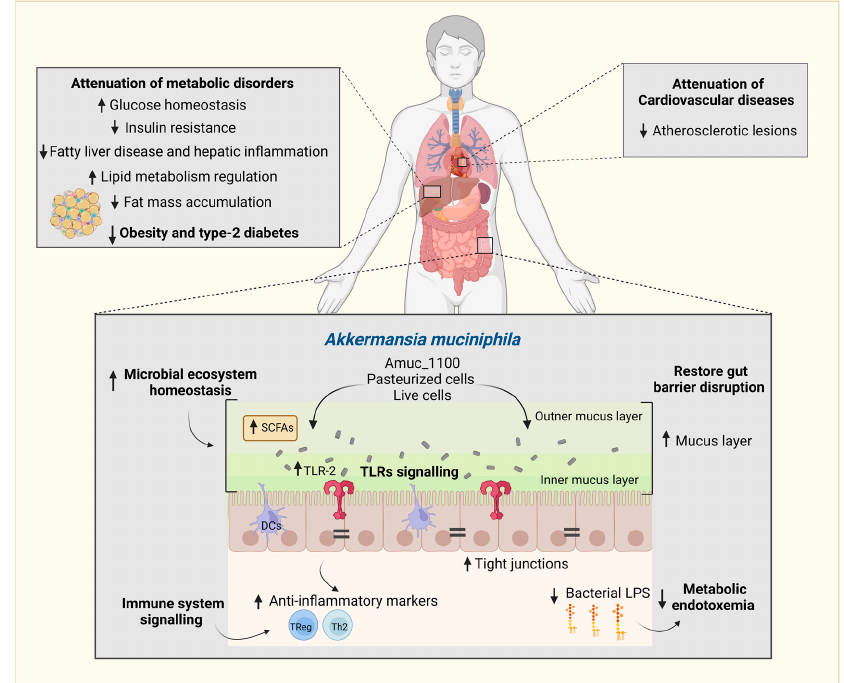
Figure 1. Beneficial impact of Akkermansia muciniphila on host health. A. muciniphila protects against cardiovascular diseases, metabolic disorders, and intestinal microecological disruption. An increased relative proportion of A. muciniphila in the gut microbiota has been inversely associated with obesity and type 2 diabetes. The administration of active A. muciniphila ; its membrane protein, Amuc_1100; and pasteurized cells can reverse metabolic disorders associated with a high-fat diet, obesity, and type 2 diabetes. Clinical and preclinical studies highlight the role of A. muciniphila in attenuating fat mass accumulation, adipose tissue inflammation, insulin resistance, and glucose homeostasis. A. muciniphila alleviates chronic intestinal inflammation and metabolic endotoxemia (reduces the level of lipopolysaccharide (LPS)) and induces immune cell and Toll-like receptor (TLR)-2 signaling. Owing to its glycan-degrading capabilities and proximity to the host colonic epithelium, this bacterium contributes to the maintenance of the mucus layer barrier function and intestinal homeostasis. The graph was created with